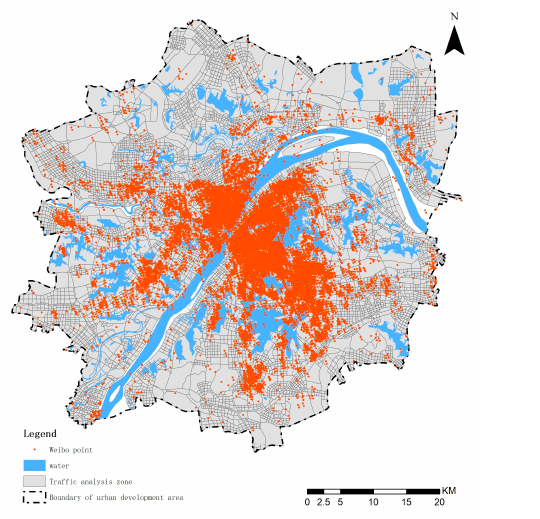
Table 2. Part of the traffic dynamics data display.